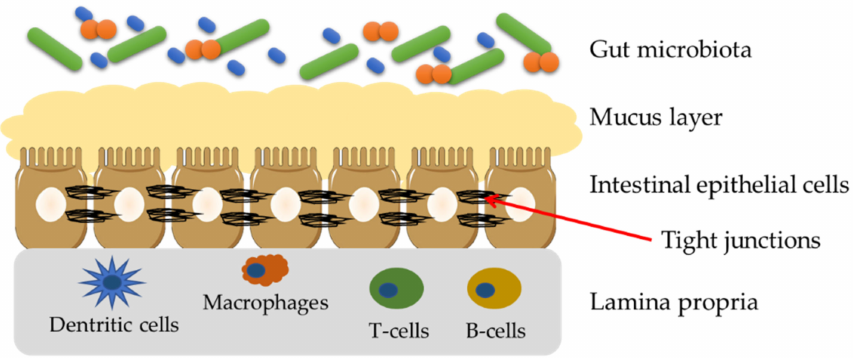
Figure 3. The scheme of the gut